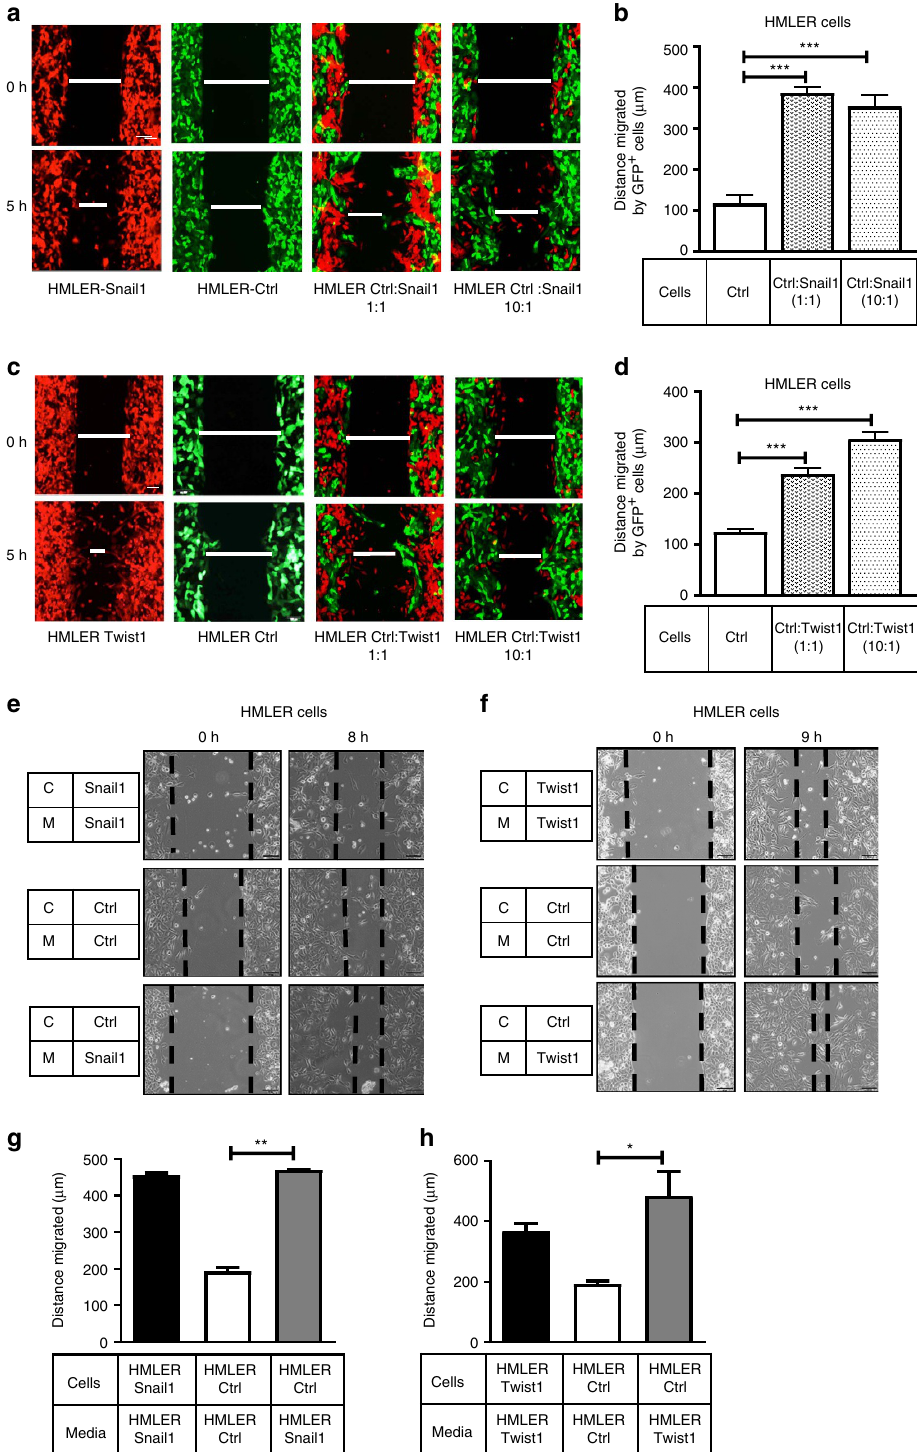
Figure 1 | Snail1 and Twist1 non-cell autonomously increase metastatic properties of control cells. Five hour migration assay performed on ( a , c ) tRFP þ HMLER-Snail1/Twist1 cells alone, GFP þ HMLER-Ctrl cells alone, or a mixture of the two cell types at 1:1 or 10:1 ratio. ( b , d ) Quantification of GFP þ cell migration in a , c . ( e , f ) Representative 8–9h migration assays of HMLER-Ctrl cells cultured in CM from ( e ) HMLER-Snail1 cells and ( f ) HMLER-Twist1 cells; C-cells, M-Media. ( g , h ) Quantification of cell migration in e , f . Scale bar, 100 m m, s.e.m. shown, n Z 3. One-way ANOVA with Tukey’s post test in all cases. * P o 0.05, ** P o 0.01 and *** P o 0.001.